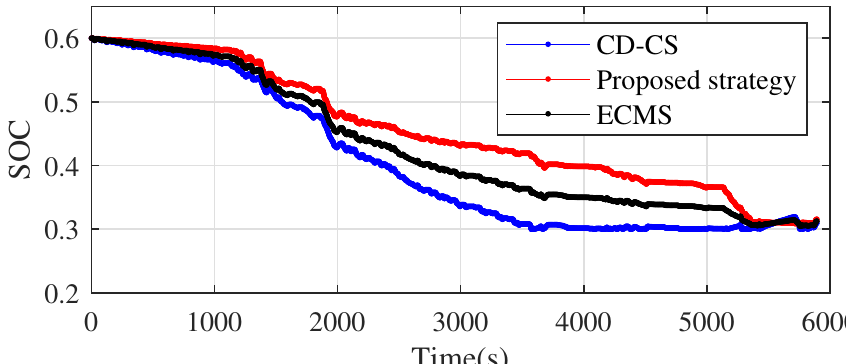
Figure 14. The results of the SOC under three control strategies.